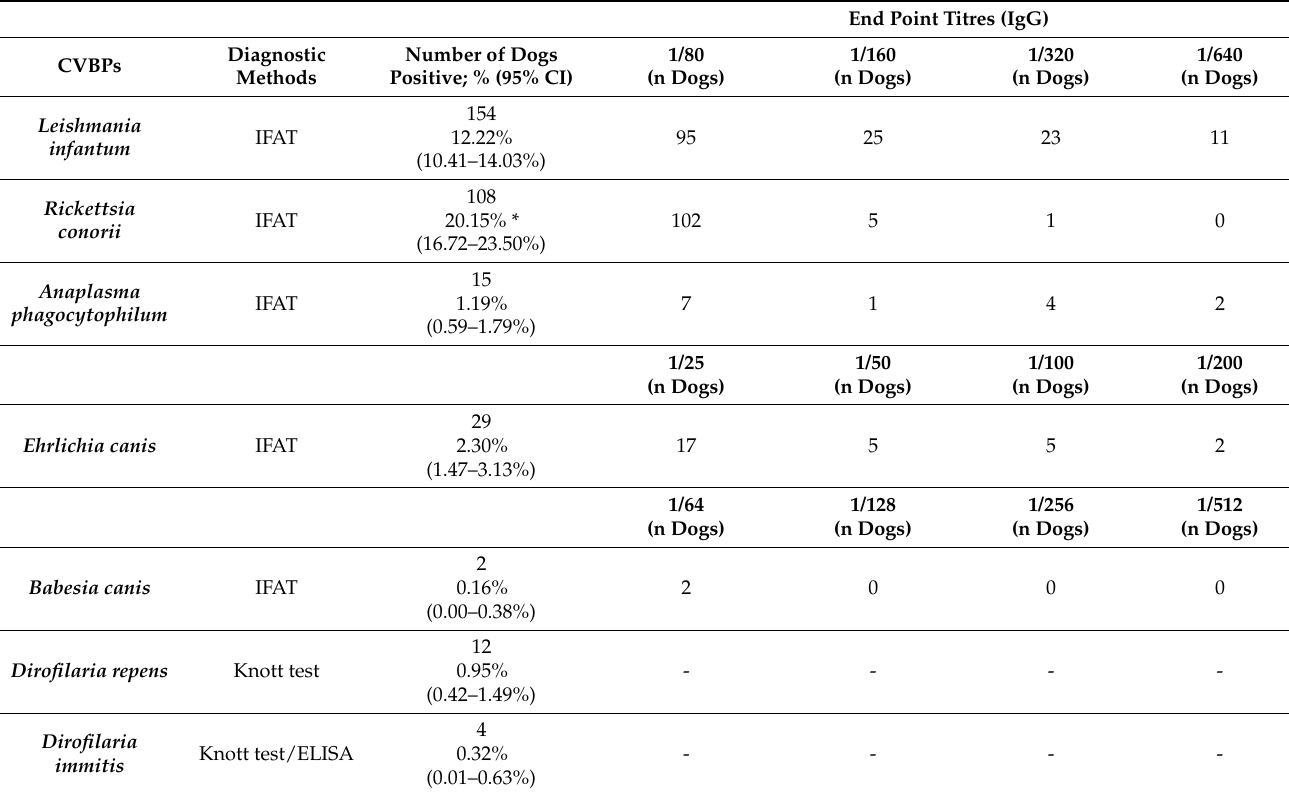
Table 1. Parasitological results of CVBPs detected in blood donor dogs during a decade of blood bank activities (2012–2021).